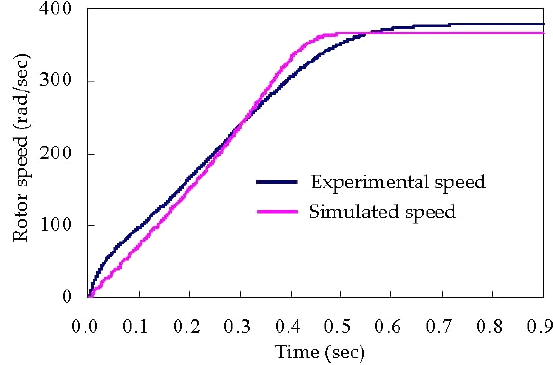
Figure 8. Comparison of speeds.